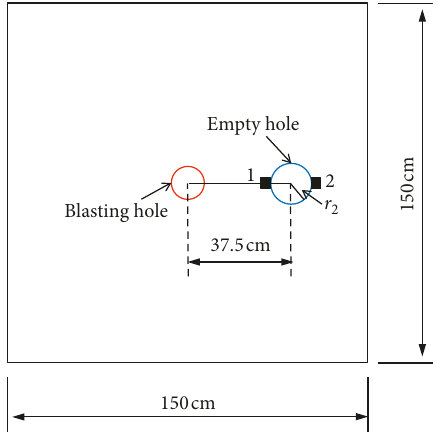
Figure 11: Comparison test of different adjacent empty hole radii. Table 5: Experimental group parameters of different adjacent empty hole radii.